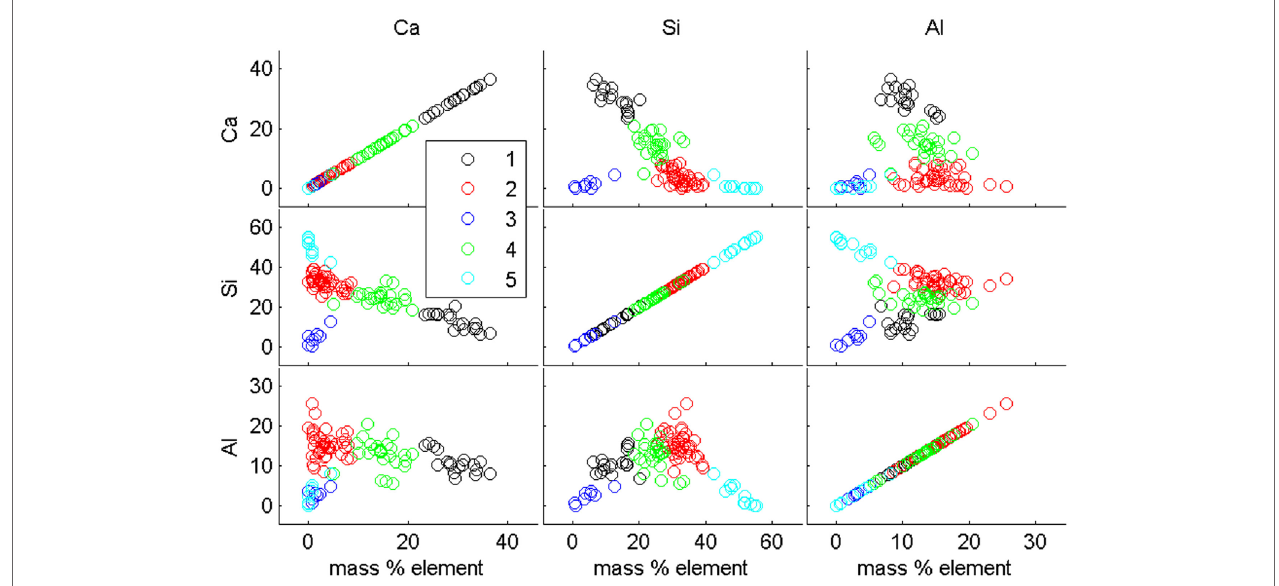
FigUre 1 | K -means cluster result for the Ml fly ash showing just the calcium, silicon, and aluminum plotted against one another with five clusters as the selected k